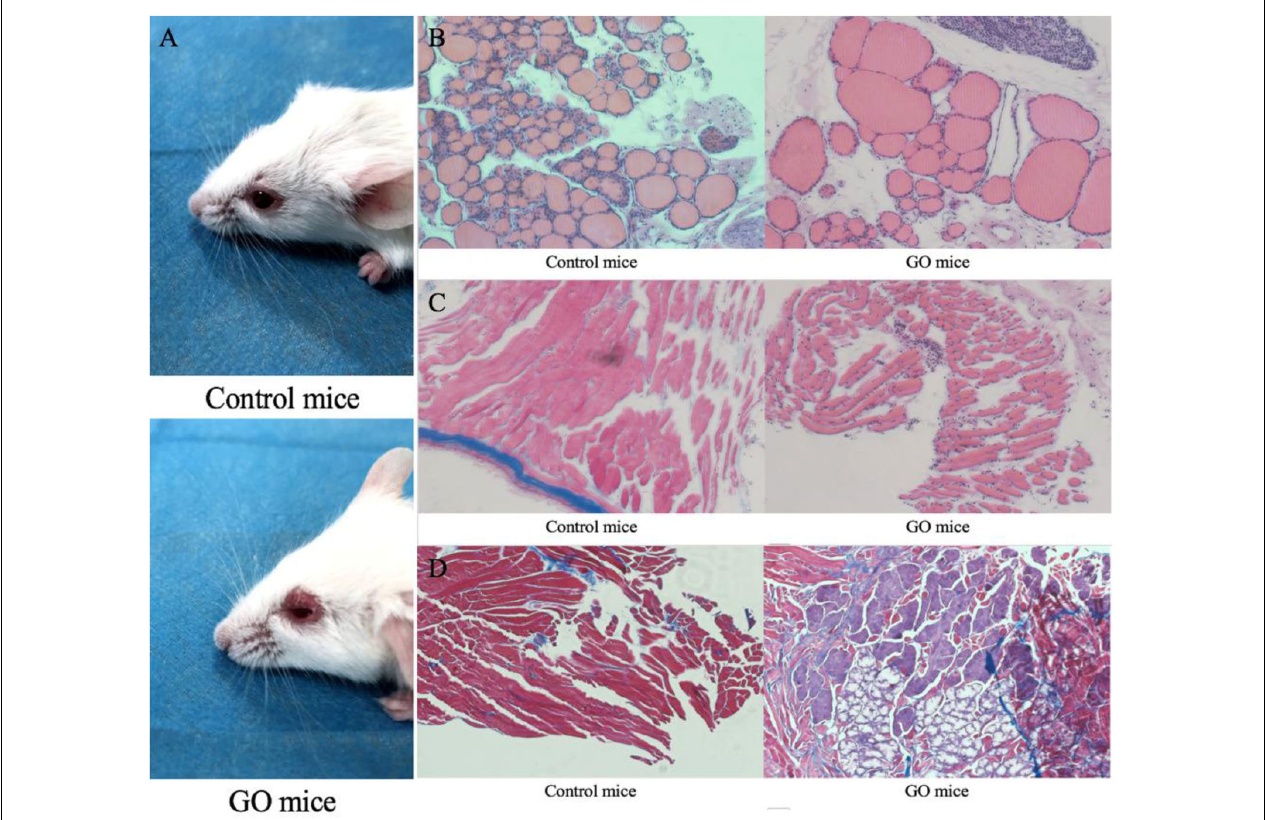
FIGURE 1 | GO mice model and Pathological images. (A) control mice and appearance of head region of hTSHR-A subunit plasmid-immunized mouse undergoing chemosis; (B) control mice normal thyroid and GO mice hypothyroid gland; (C) control mice H&E staining performed normal extraocular muscles and GO mice extraocular muscles showing interstitial inflammatory infiltrate; and (D) GO mice Masson’s Trichrome-stained section of orbital muscle to show fibrosis in extraocular muscles and control mice did not show fibrosis.